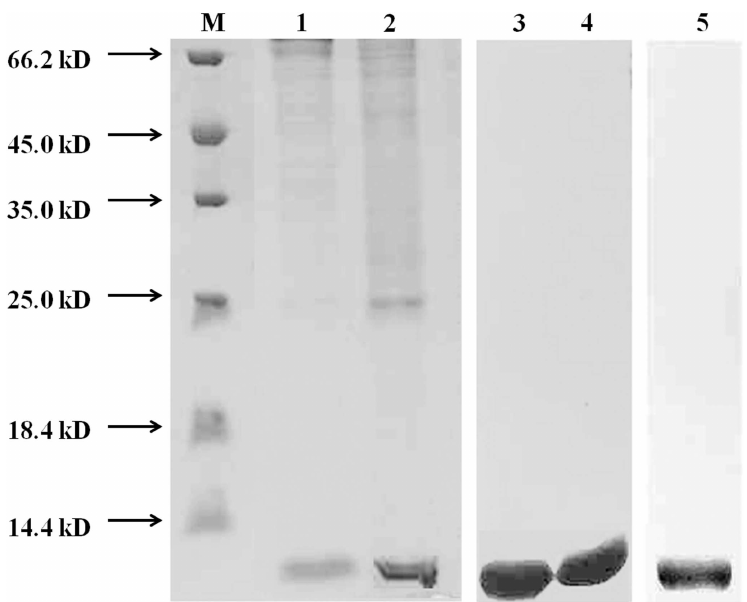
Fig 2. SDS-PAGE and western blot analysis of purified recombinant MT. M: protein molecularweight markers; lane 1: MT separated with 150 mM imidazole; lane 2: MT separated with 50 mM imidazole; lane 3 and 4: Western blot of recombinedMT with anti-6Hisantibody; lane 5: Western blot of recombined MT fusion protein with purifiedMT antiserum. https://doi.org/10.1371/journal.pone.0174482.g002 1:160,000 values could meet the standard of judgment, and the correlation between the OD 450 and coated MT concentration was better. Therefore, it was necessary to analyze the regression curve of diluted MT-antibody 1:120,000, 1:140,000, and 1:160,000. For the same MT concen- tration, the value of MT-antibody dilution groups (1:120,000, 1:140,000) was higher than that of 1:160,000, while correlation of the regression curve at 1:160,000 was higher than that of the former two groups (Fig 3A–3C). Therefore, MT antiserum dilution factor was 1:160,000 under the present experimental conditions. Table 4 showed the results of different coating periods on OD Significant differences 450. could be observed during 8 hours compared with to 12 and 16 hours. There was no significant difference between 12 and 16 hours. The coating period of 12 hours seemed to be suitable for our experiment.